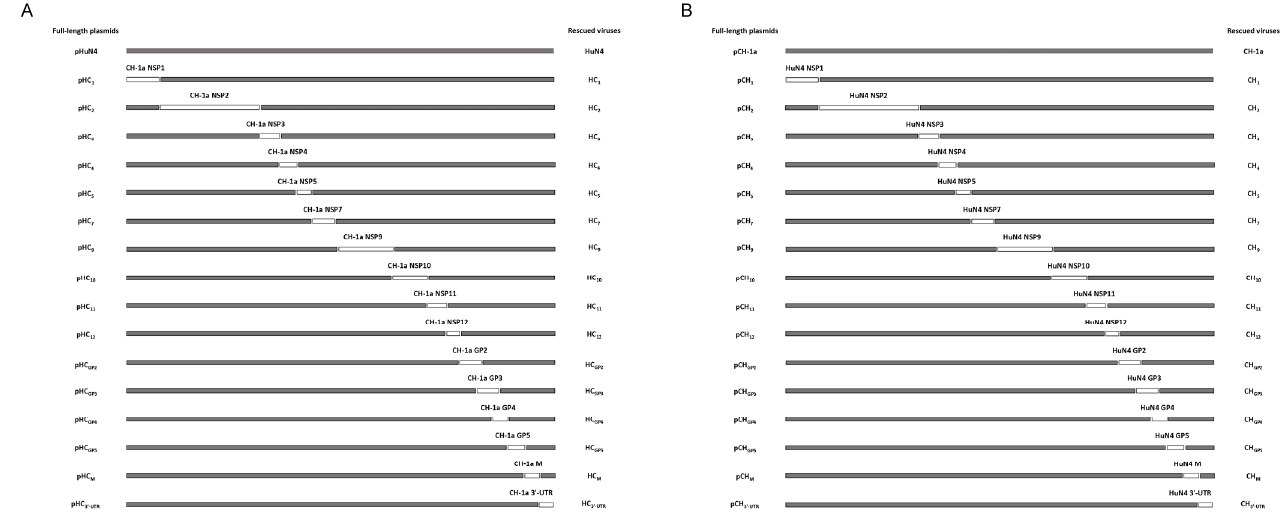
Figure 1. Construction strategy of the full-length chimeric plasmids. ( A , B ) Full-length chimeric plasmids were constructed by exchanging the corresponding NSP1, NSP2, NSP3, NSP4, NSP5, NSP7, NSP9, NSP10, NSP11, NSP12, GP2, GP3, GP4, GP5, M and 3 ′ -UTR regions between CH-1a and HuN4 infectious clone. NSP6, NSP8 and N proteins are highly homologous. The boxes represent genomic fragments of parental backbone viruses HuN4 (gray) and CH-1a (white).